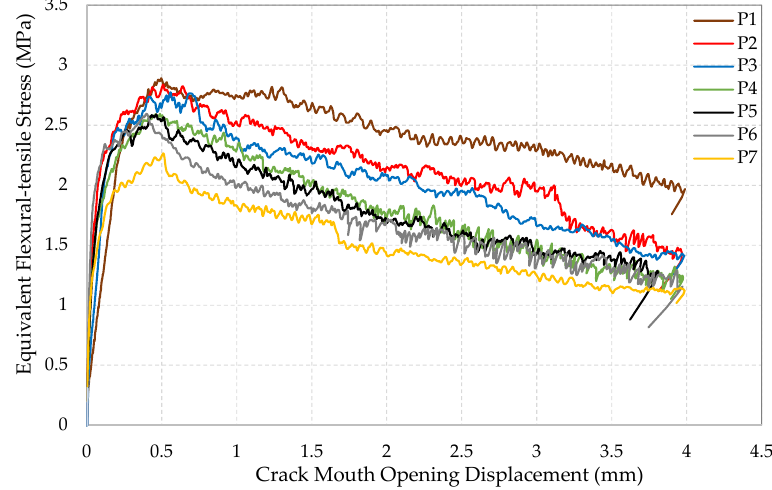
Figure 6. Equivalent Flexural-tensile stress vs. CMOD.